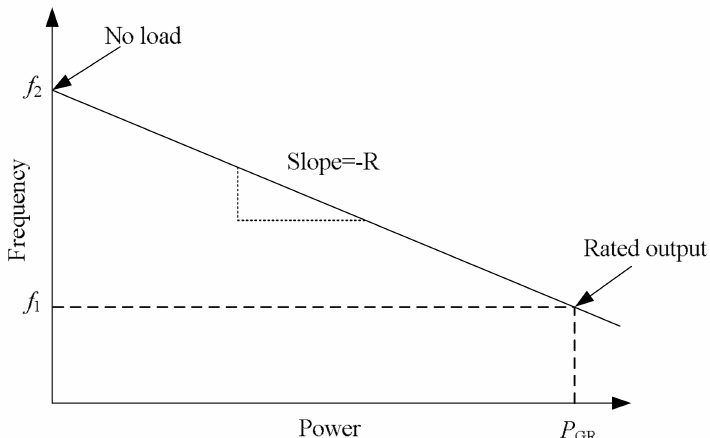
Figure 1. Per-unit regulation characteristic of a generating